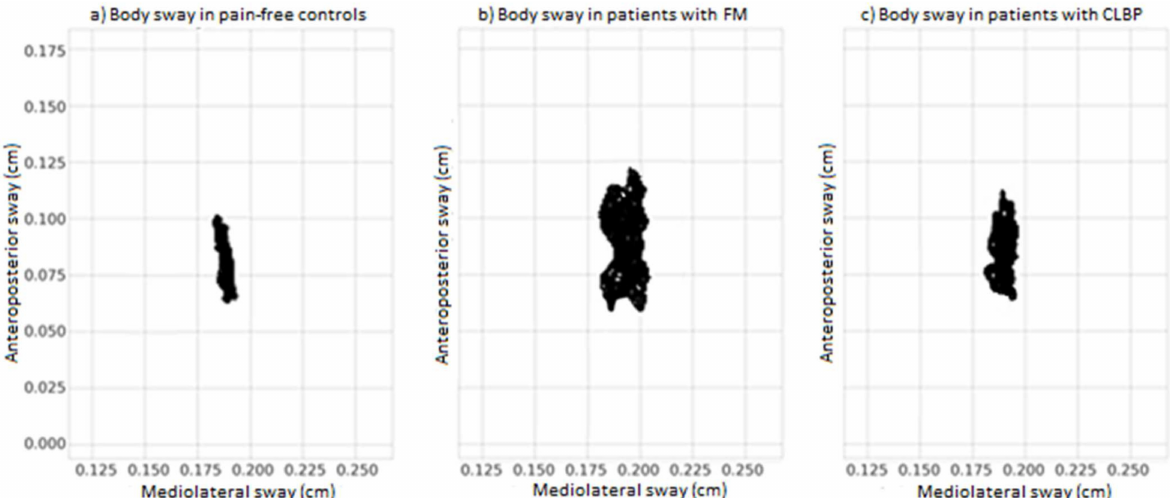
Figure 3. Diagrams of the mean body sway in the anteroposterior and mediolateral directions for the three groups of participants (pain-free controls, fibromyalgia and chronic low back pain). ( a ) Body sway in pain-free controls. ( b ) Body sway in patients with FM. ( c ) Body sway in patients with